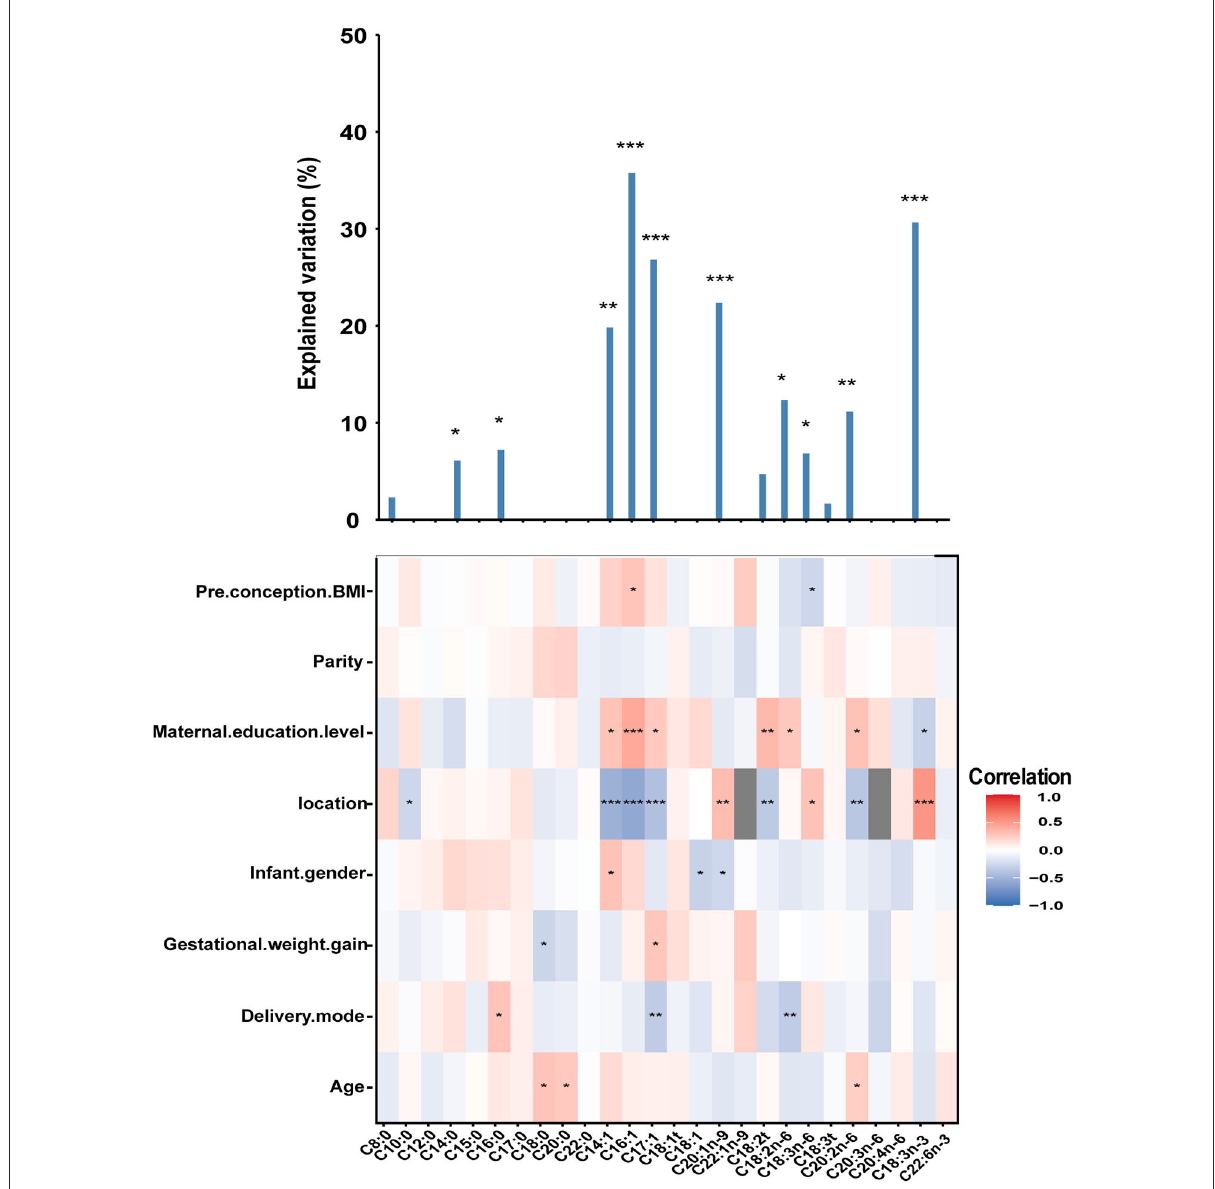
FIGURE2 The column chart shows the total contribution of indicators to the interpretation of sn-2 FAs variation (obtained by multiple linear regressions). The heat map shows the Spearman correlations between sn-2 FAs and correlated factors. Coloring reflects the direction and magnitude of the correlation coefficients. For pre-conception BMI, parity, maternal education level, gestational weight gain, and age, the higher the value/level of the correlated factors, the higher the fatty acid content. For the location, red indicates FAs in Danyang are higher than that in Beijing. For infant gender, red indicates FAs in mothers with baby girls are higher than that with baby boys. For delivery mode, red indicates FAs of mothers with natural childbirth are lower than with other modes of delivery. The major predictors were identified based on correlation and the best multiple regression model. DHA, Docosahexaenoic acid (C22:6n-3). * P < 0.05; ** P < 0.01; ***, P < 0.001.